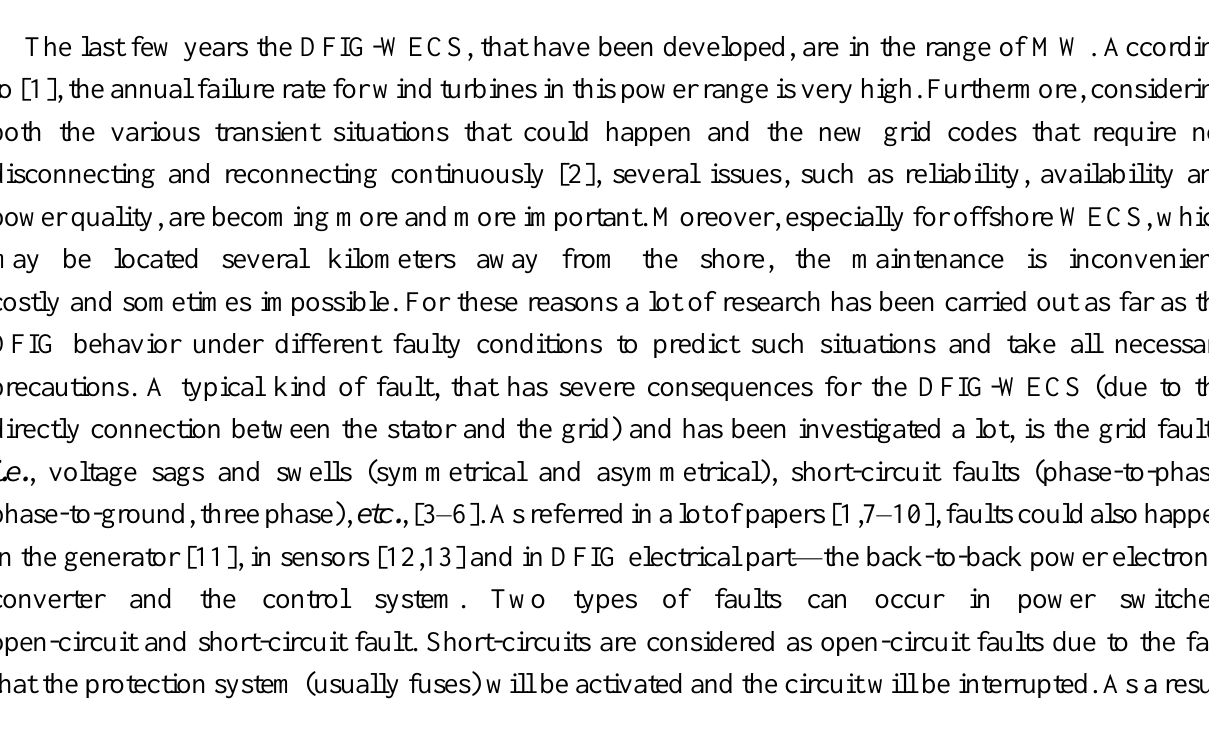
Figure 1. Doubly-Fed Induction Generator based Wind Energy Conversion